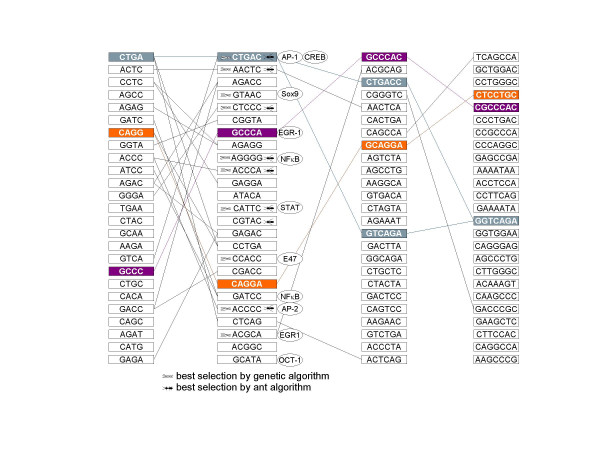
Biological relevance. Linkage of the transcription-factor binding motifs among the ant algorithm prediction, the genetic algorithm prediction, and the biologically known binding motifs.